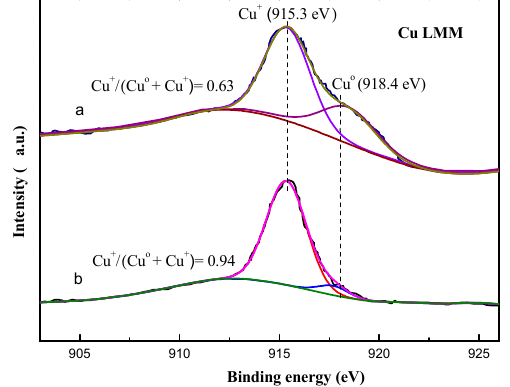
Figure 9. Cu LMM X-ray excited Auger electron spectroscopy (XAES) spectra of used Cu 2 O samples after 24 h reaction. ( a ) Cu 2 O-NO 3 ; ( b ) Cu 2 O-Cl(2). Before characterization, the catalysts were washed with deionized water and dried in a vacuum for 12 h at 30 ◦ C.